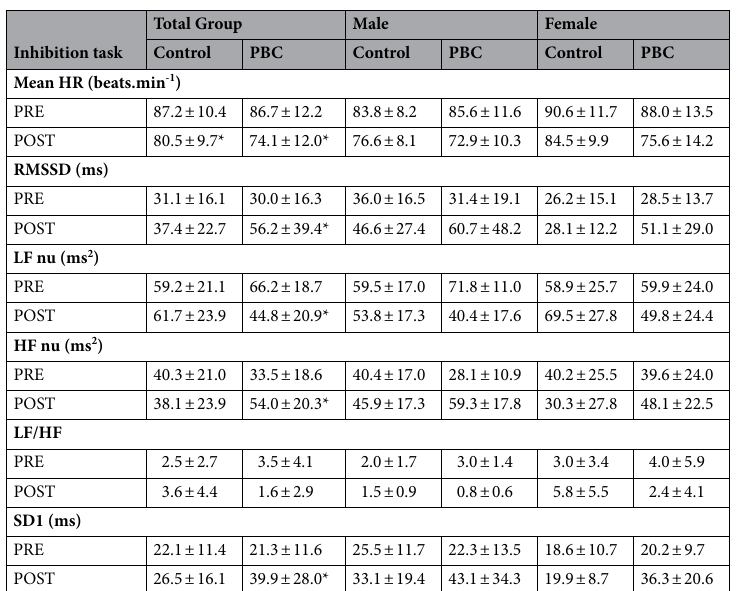
Table 3. Heart rate variabilty responses to partial body cryotherapy. Data are presented as mean ± SD. PBC partial body cryotherapy. *POST significantly different from PRE (P <